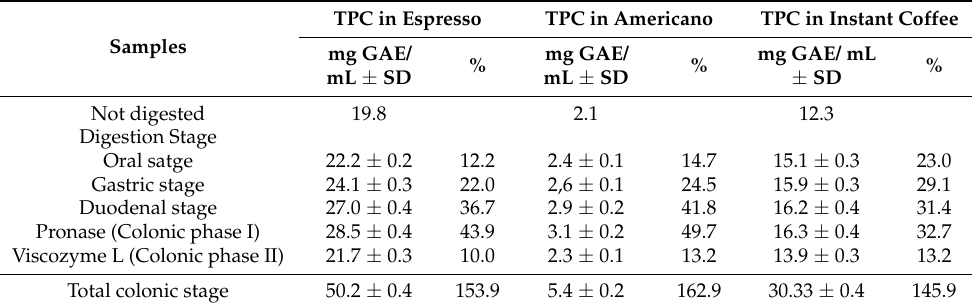
Table 3. Total phenol content (TPC) of assayed samples (not-digested vs. digested stages).